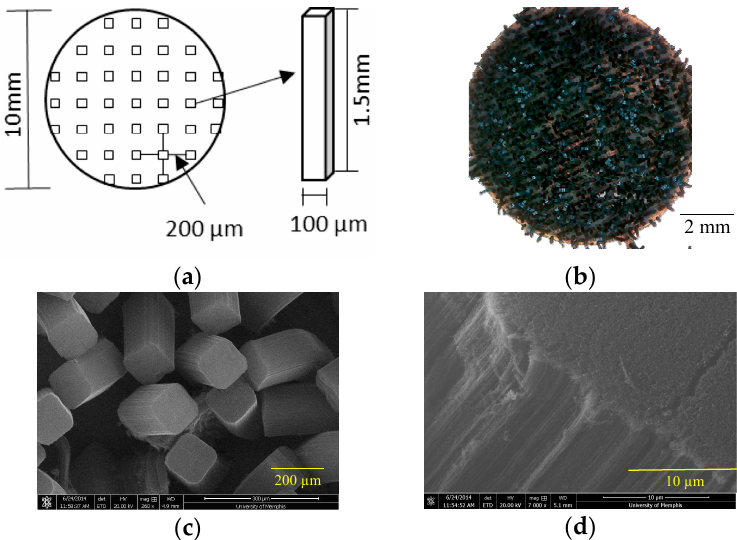
Figure 1. ( a ) Schematic design of the pillar and the pattern of patterned vertically-aligned Carbon NanoTubes (pvCNT) growth on stainless steel substrate. ( b ) Optical microscope image of a pvCNT electrode (200 µm spacing). ( c ) Scanning electron microscope (SEM) image (top view) of a pvCNT electrode (200 µm spacing) showing the pillars formed with vertically aligned CNT fibers. ( d ) SEM image of the top corner of a pillar.